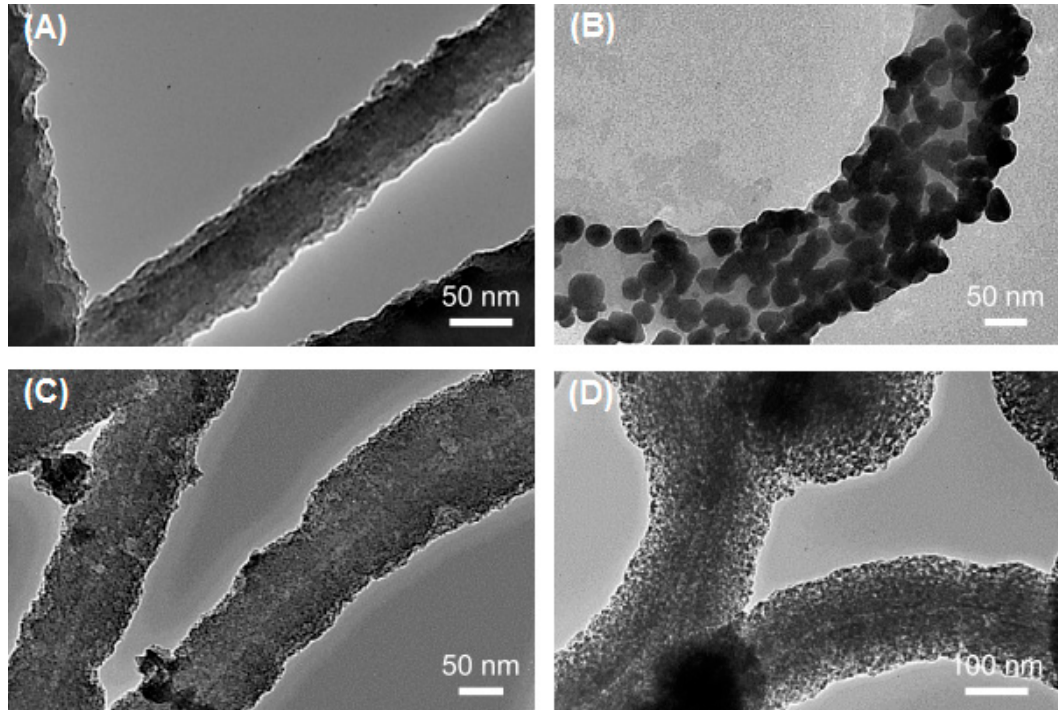
Figure 1. Transmission electron microscope (TEM) micrographs of pristine and metalized Flagella-templated silica nanotubes. ( A ) Pristine silica nanotubes fabricated on flagella bio-templates. ( B ) Gold, ( C ) palladium, and ( D ) iron oxide nanoparticles deposited on the silica nanotubes. (Reprinted with permission from Jo et al . Nanotechnology 24 , 13574 (2013) [33]).